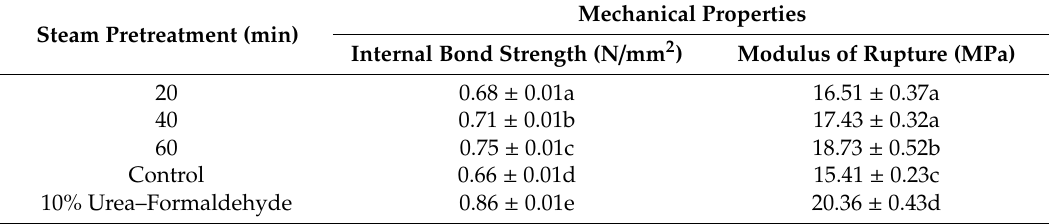
Table 5. Mechanical strength properties of particleboard made without synthetic adhesive with steam-pretreated